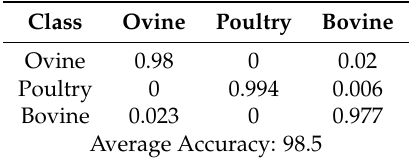
Table 3. Confusion matrix of the training